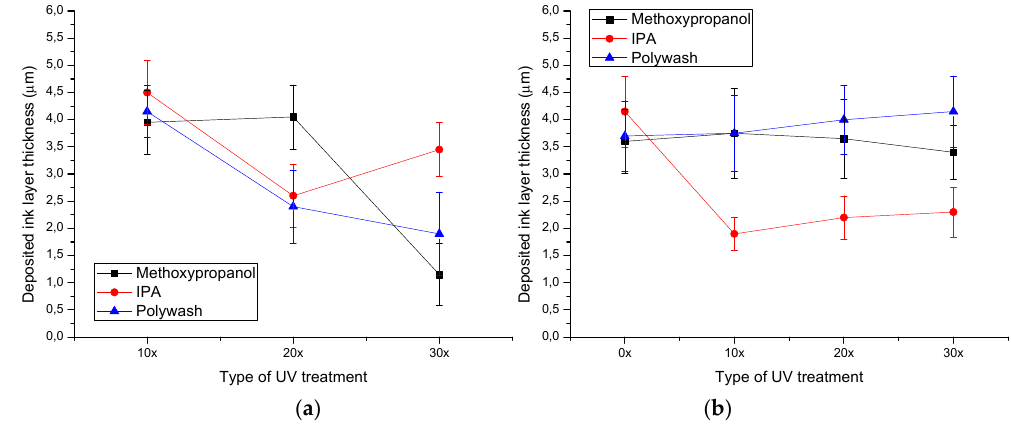
Figure 22. Thickness of ink film deposited by modified printing plates: ( a ) Photopolymer plate, ( b ) EPDM plate.